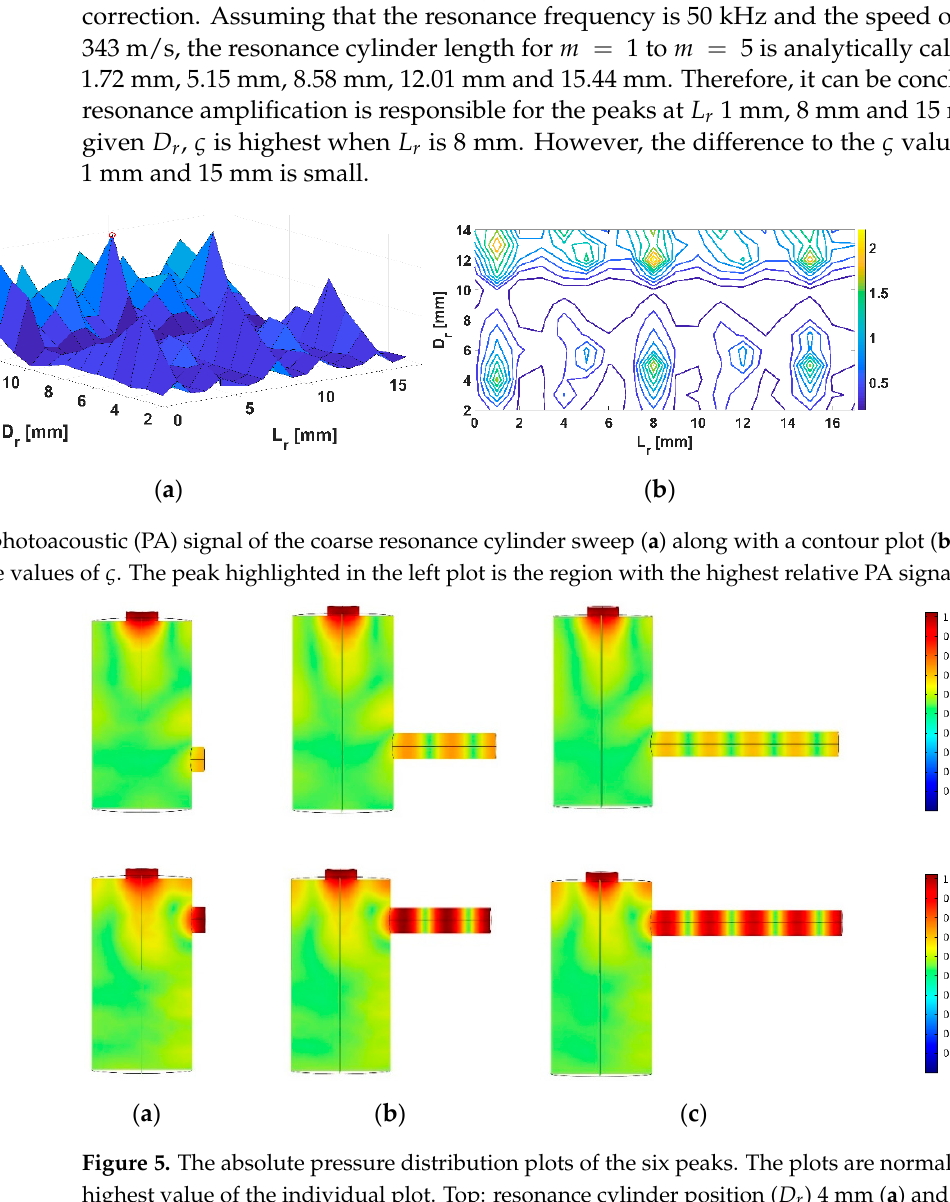
Figure 5. The absolute pressure distribution plots of the six peaks. The plots are normalized by the highest value of the individual plot. Top: resonance cylinder position ( 𝐷 (cid:3045) ) 4 mm (a) and 5 mm ( b and c). Bottom: resonance cylinder position ( 𝐷 (cid:3045) ) 12 mm. The length of the resonance cylinder ( 𝐿 (cid:3045) ) is 1 mm, 8 mm and 15 mm respectively.